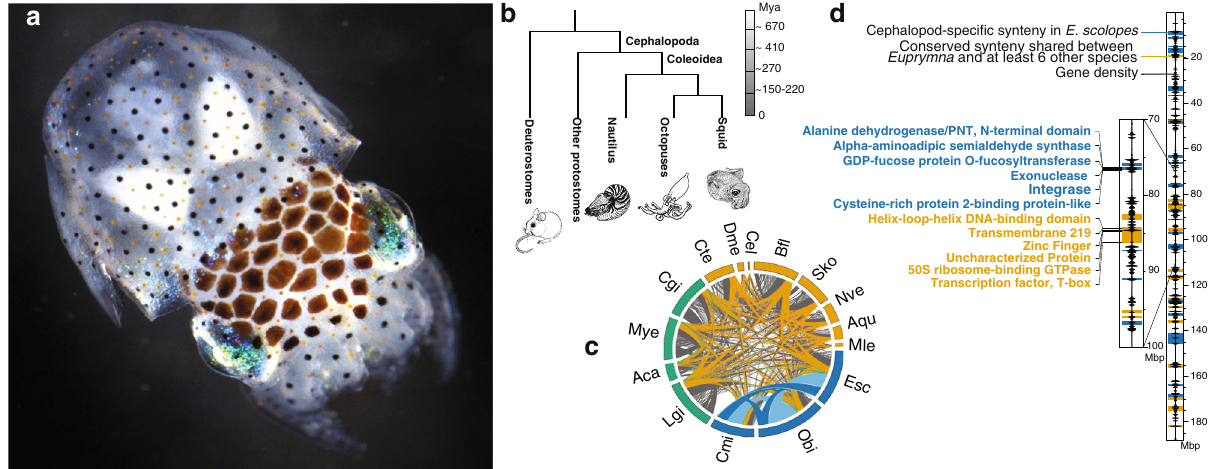
Fig. 1 Large-scale syntenic reorganization of cephalopod genomes. a Photograph of an Euprymna scolopes hatchling. b Schematic tree with divergence times of major cephalopod lineages from deuterostomes and other protostomes 53,54 . c Circos plot showing loss of syntenies conserved in other metazoans and the emergence of a large number of novel, cephalopod-speci fi c microsyntenies within cephalopods. Each line represents a syntenic cluster shared between different species. Orange lines indicate syntenic clusters shared between at least seven out of these 24 species (ancestral, metazoan clusters); green lines represent novel molluscan syntenies, shared between fi ve or more molluscs but not present in any non-molluscan species. Blue lines represent cephalopod-speci fi c syntenies shared between either all three cephalopod species (dark blue) or two of the three cephalopod species (light blue) but not present in any non-cephalopod species; gray lines represent other syntenies that do not fall in either of the previous categories. Abbreviations: Aca - Acanthaster planci , Aqu – Amphimedon queenslandica , B fl - Branchiostoma fl oridae ,Cel - Caenorhabditis elegans , Cgi - Crassostrea gigas , Cmi - Callistoctopus minor , Cte - Capitella teleta , Dme - Drosophila melanogaster , Esc – Euprymna scolopes , Lgi - Lottia gigantea , Mle - Mnemiopsis leidyi , Mye - Mizuhopecten yessoensis , Nve - Nematostella vectensis , Obi – Octopus bimaculoides , Sko - Saccoglossus kowalevskii d Example of one whole chromosomal-scale scaffold (right) of E. scolopes showing the distribution of gene density, cephalopod-speci fi c (blue) and conserved, metazoan (orange) syntenies. Inset (left) with locations of genes within two speci fi c syntenic